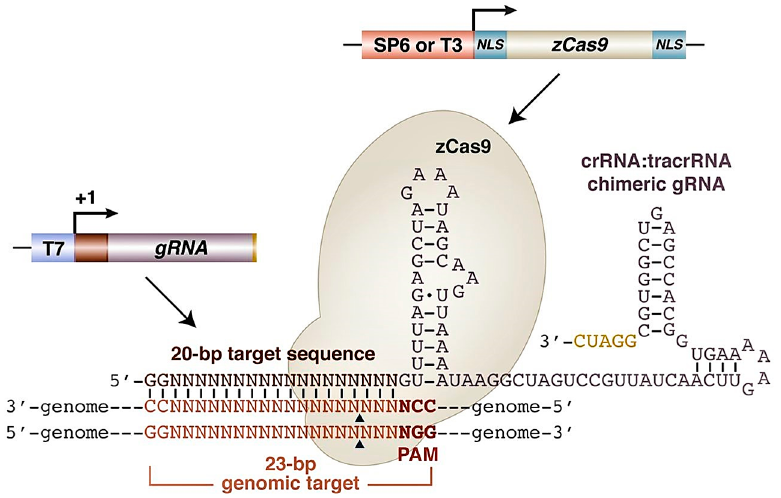
Figure 8. Genome editing with CRISPR/Cas9 nuclease system in zebra fi sh ( Danio rerio ) [99].